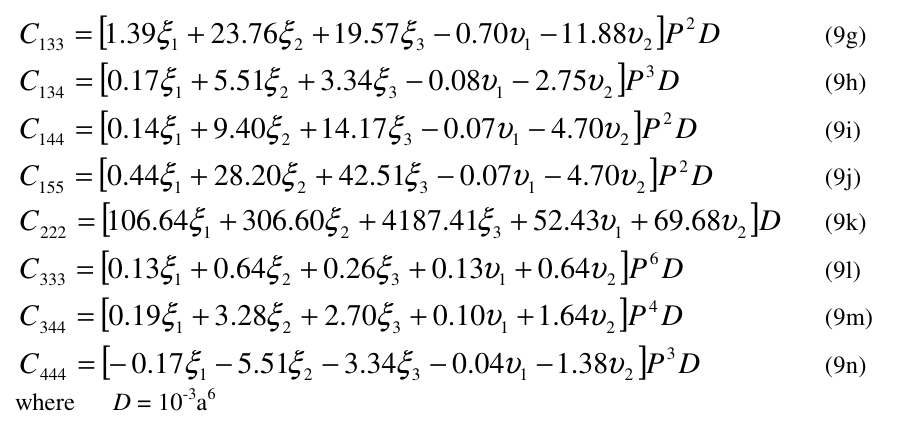
Table 2 Second-order elastic constants of LiNbO 3 (in G Pa) along with the reported